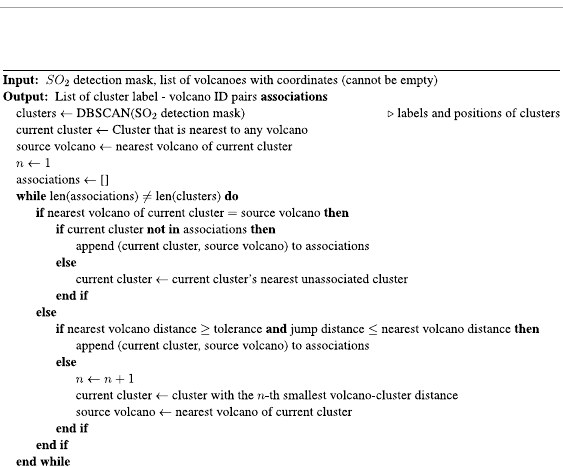
FIGURE 4 Iterativeuseofbinaryclassi fi ersonthesameimagecanresult in overlapping classi fi